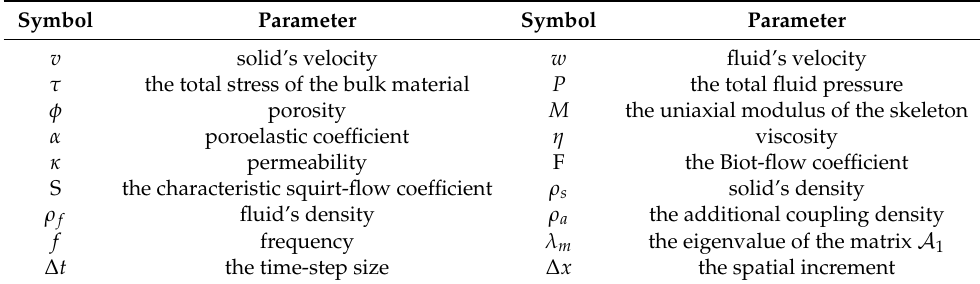
Table A1. Symbols of the parameters.